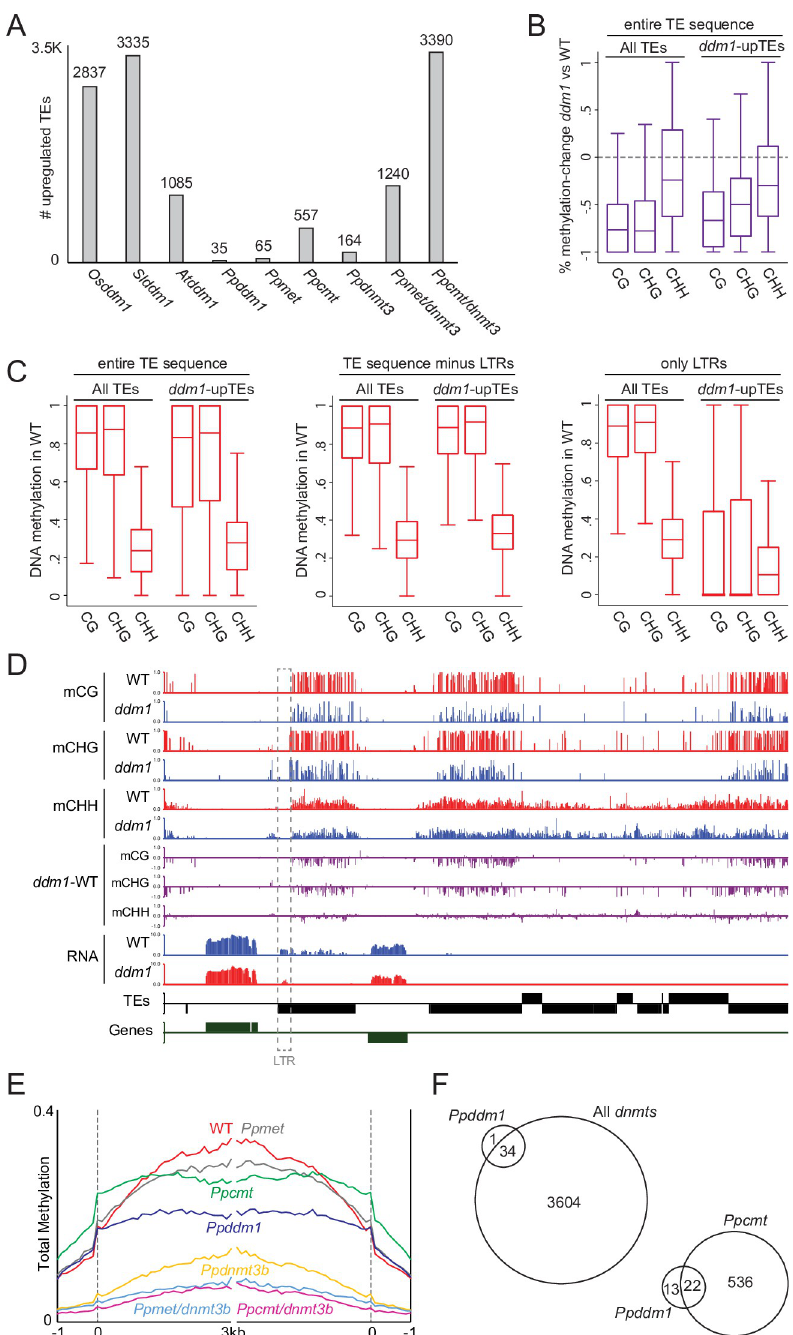
Fig 3. PpDDM1 knockout upregulated a small number of TEs. A. Number of upregulated TEs in indicated DDM1 and DNMT mutants. Osddm1 and Slddm1 are Oryza sativa and Solanum lycopersicum plants, respectively, that are each mutated in two DDM1 genes ( ddm1a and ddm1b ) [16,21].At ddm1 is an Arabidopsis ddm1 mutant [2]. P . patens met , cmt , and dnmt3 mutations are notated with the Prefix Pp [26]. Osddm1 , Slddm1 , and Atddm1 data are from leaves or roots, and all P . patens samples were from protonema. B. Percent methylation change between Ppddm1 and wild type in all versus Ppddm1 -upregulated TEs. C. Wild type DNA methylation in all TEs versus Ppddm1 -upregulated TEs across the entire TE sequence (left panel), internal TE sequences (middle panel), or only within long terminal repeat (LTR) sequences (right panel). D. A genomic representative snapshot of hypo-methylated upregulated and unaffected TEs in Ppddm1 . The dotted line marks an LTR region that is already hypomethylated and expressed in wild type. E. Total methylation (CG, CHG, and CHH methylation combined) across TEs in wild type, Ppddm1 , and Ppcmt . F. Venn diagram of upregulated TEs in Ppddm1 and all Ppdnmts (left diagram) or Ppcmt (right diagram). https://doi.org/10.1371/journal.pone.0279688.g003 PLOS ONE | https://doi.org/10.1371/journal.pone.0279688 March 8,